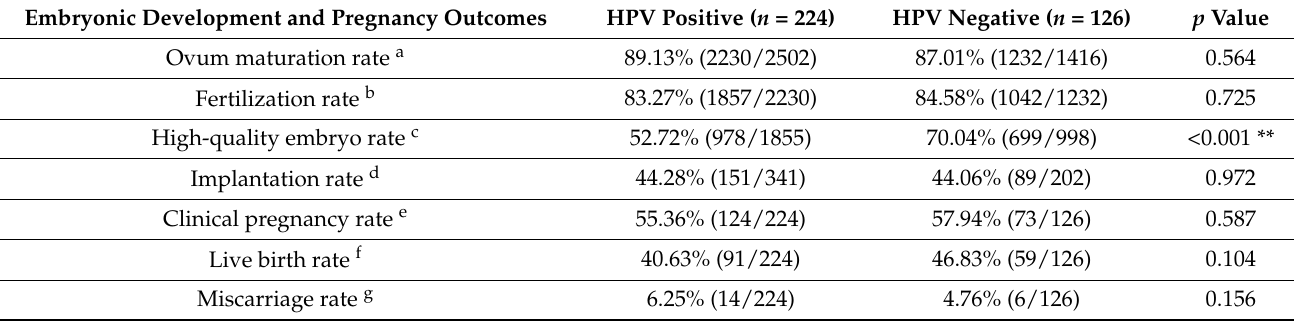
Table 2. Embryonic development and pregnancy outcomes in HPV-positive group and HPV- negative group.